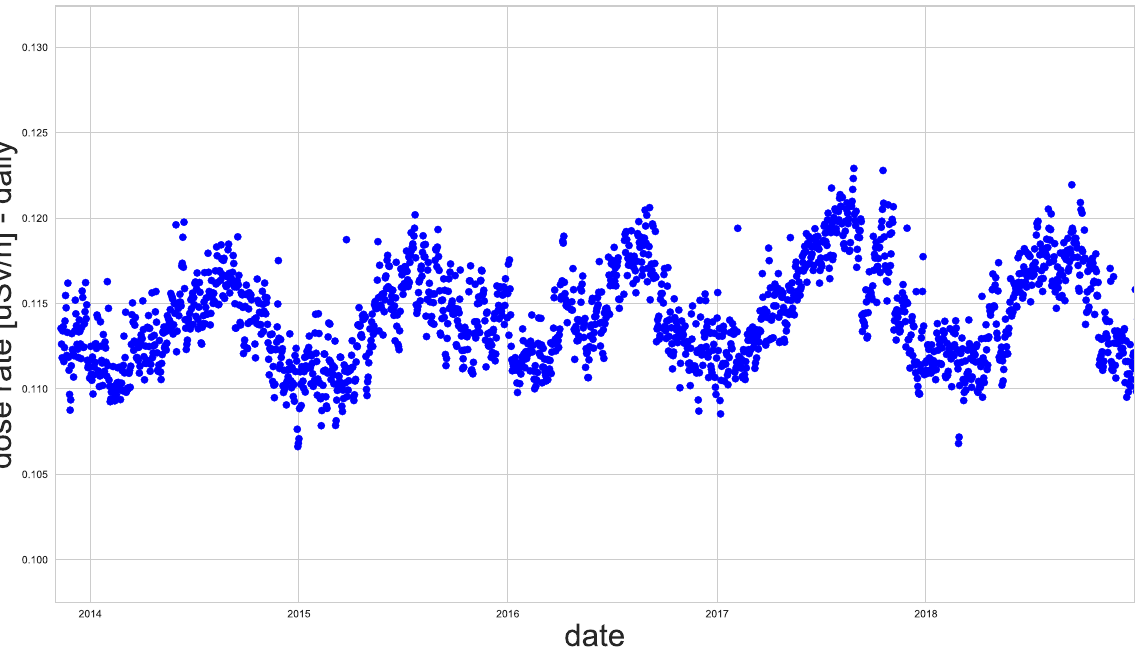
Figure 5. Daily averaged dose rate ( µ Sv/h) measured from November 2013 to December 2018, for a total of 2702 collected daily